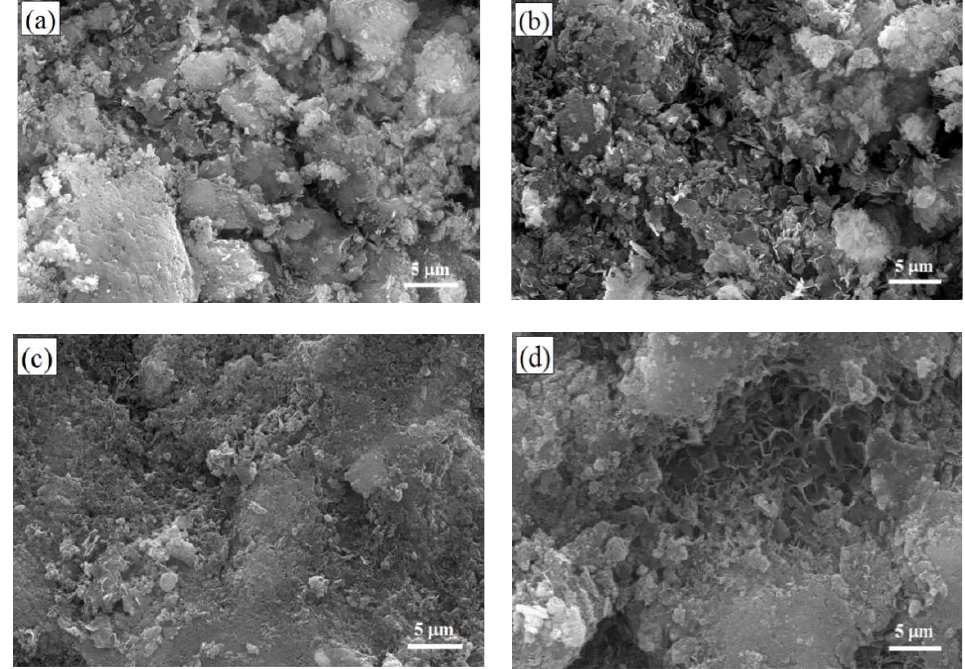
Figure 10. FESEM images of ( a ) Zn; ( b ) SiC/Zn; ( c ) POT–SiC/Zn and ( d ) PMT–SiC/Zn coatings immersed in 3.5% NaCl solution for 90 days.